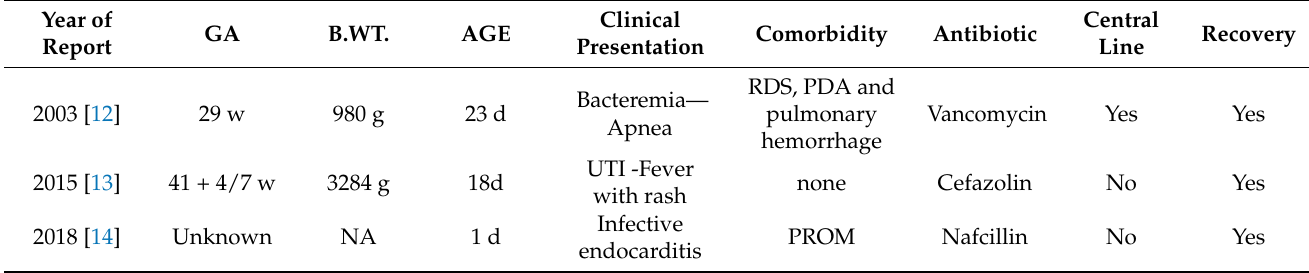
Table 3. Previously reported neonatal presentation of Staphylococcus lugdunensis